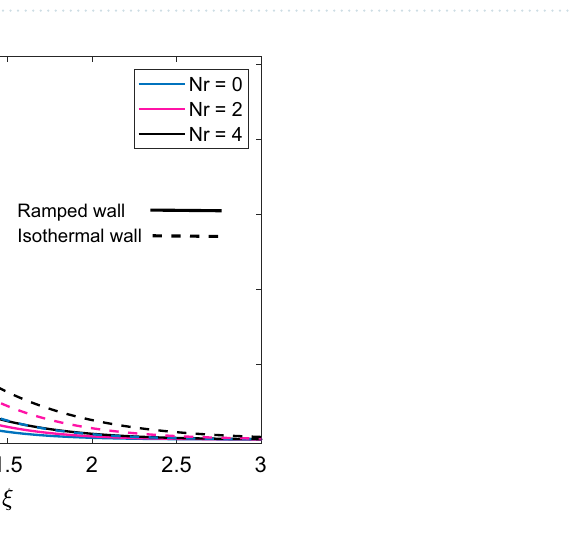
Figure 11. Velocity distribution [Eq. (39)] for various values of φ when M = 2.0 , K = 0.5 , Gr = 5.0 , Nr = 0.5 and Q = 0.5 .